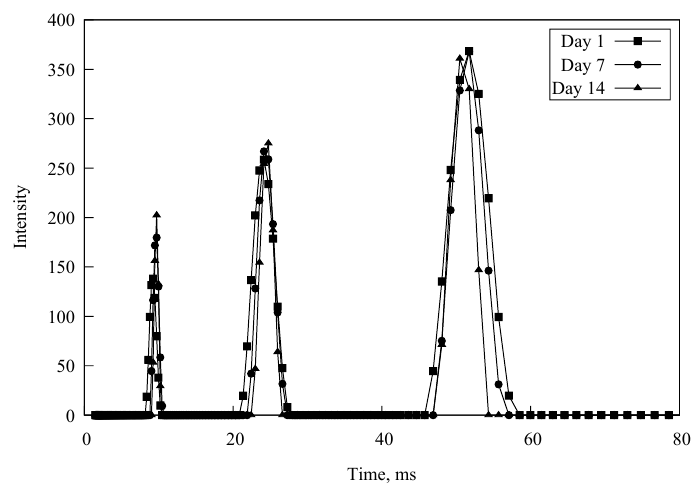
Figure 4. Oil relaxation time distribution (T 2 ) of the bulk